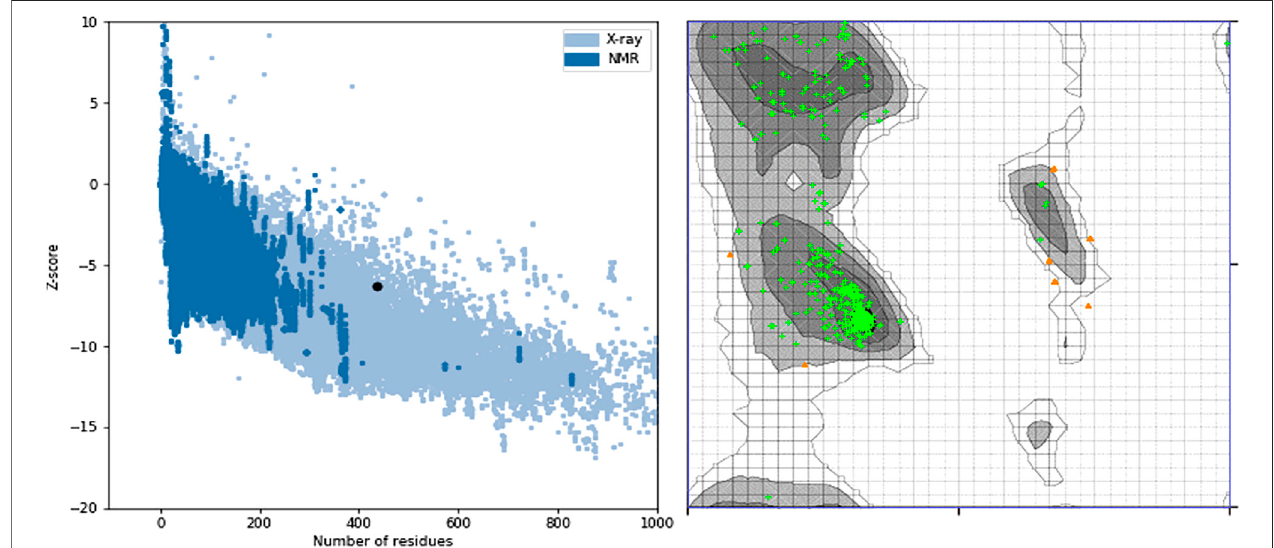
FIGURE 7 | ProSA z-score and Ramachandran plot of the SWISS-MODEL homology model. The z-score of − 6.33 suggests that the homology model is properly folded and 96.7% of the protein residues being under the favored region shows that almost all the protein residues are properly sterically placed in 3D space.